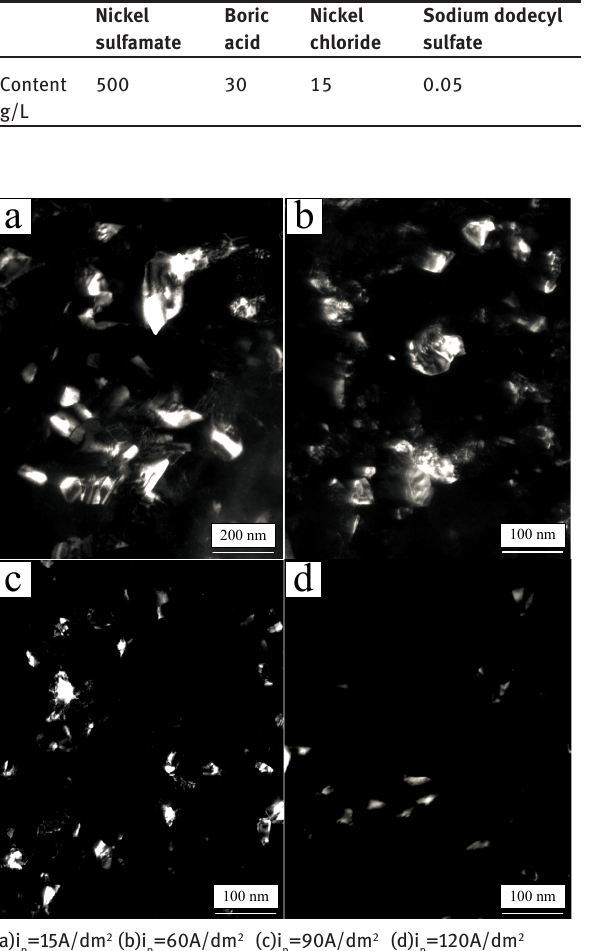
Figure 4: TEM images of the composite electroforming deposit at different peak current